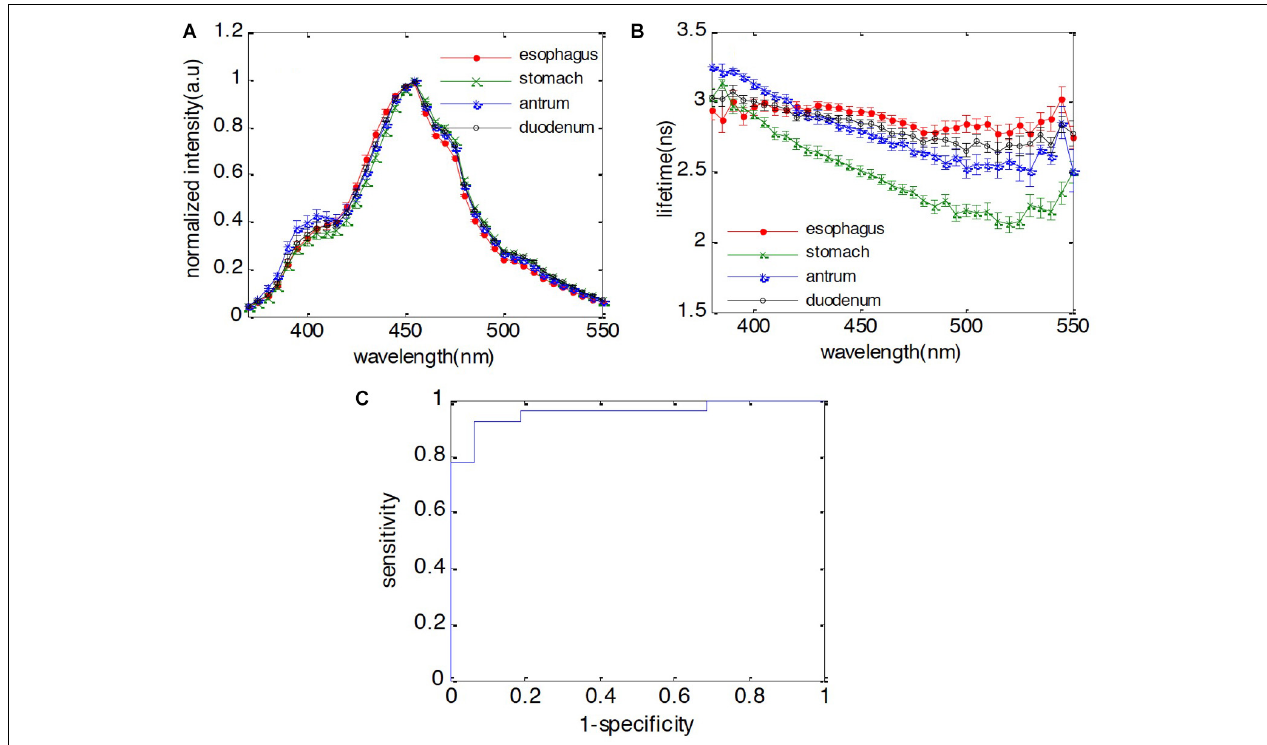
FIGURE 2 | Fluorescence characteristics of duodenum, antrum, stomach body, and esophagus. (A) Spectra; (B) lifetime; (C) receiver operating characteristic (ROC) curve of classification between duodenum and esophagus using both spectral and lifetime features. The area under curve (AUC) is 0.95.